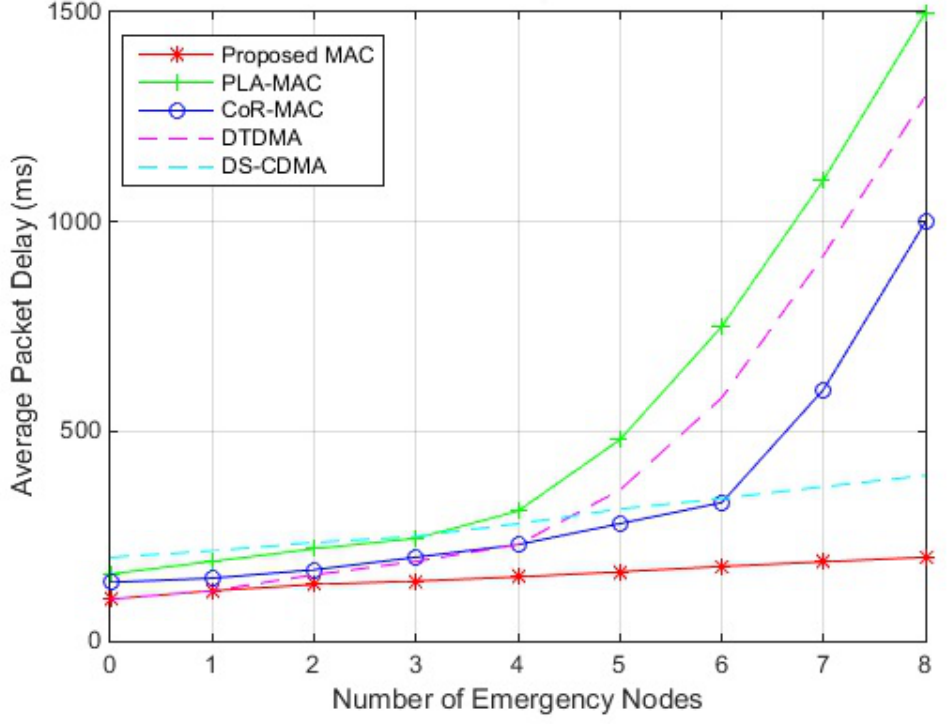
Figure 4. Delay Performance of MAC